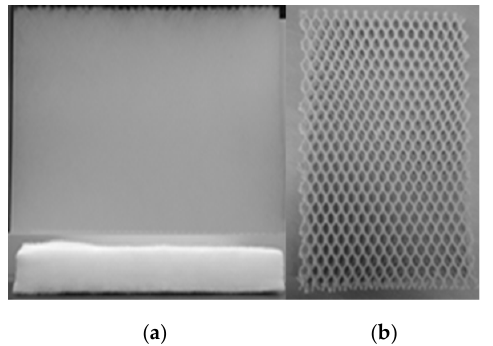
Figure 2. ( a ) Surface of the air pocket fabric and ( b ) surface of the other side.